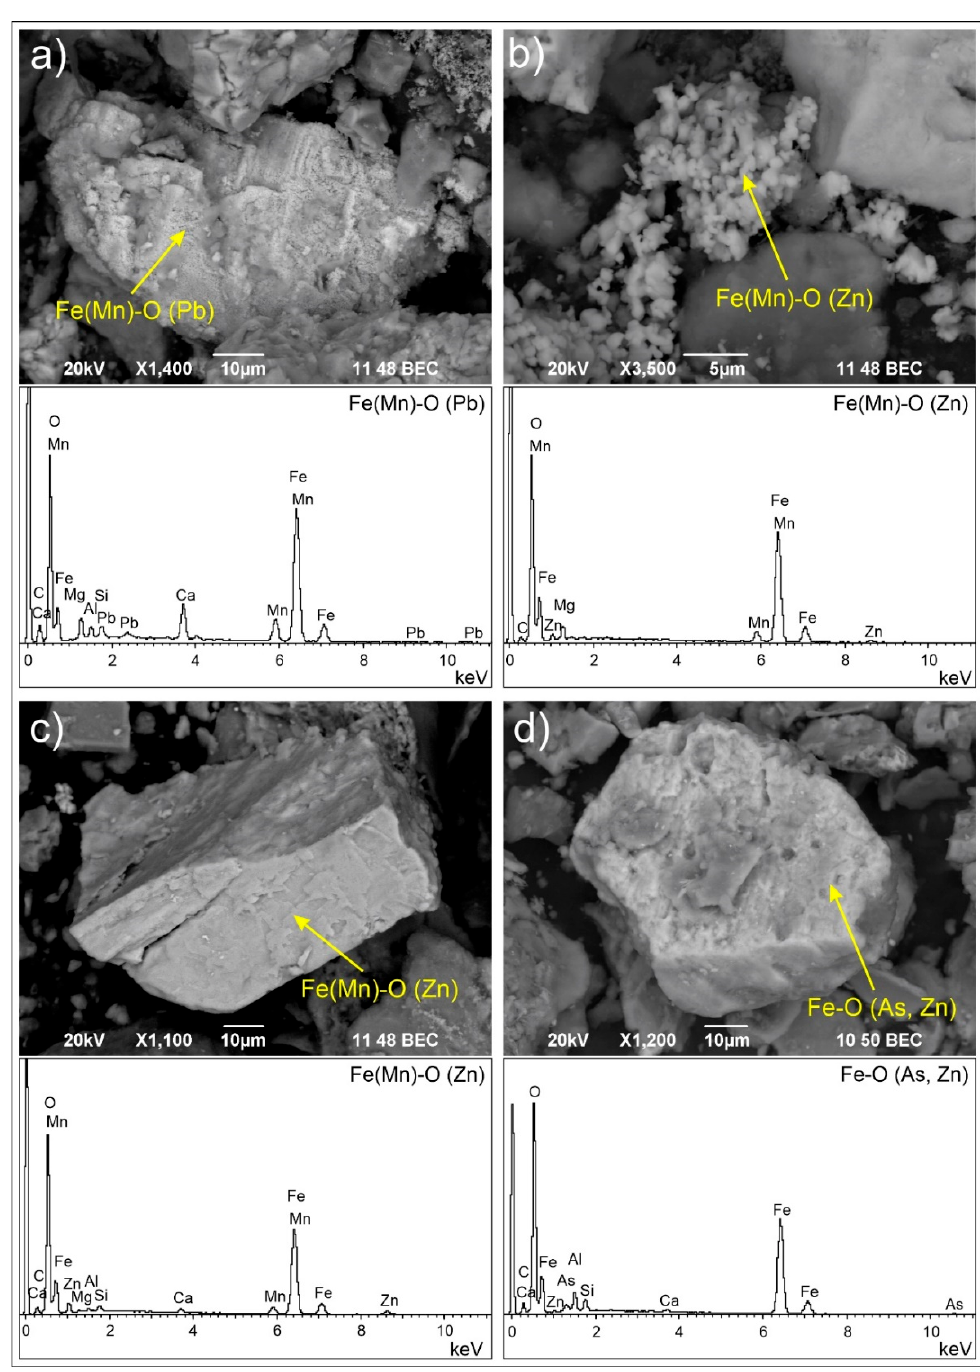
Figure 4. SEM(BSE) images and EDS spectra of solid Fe carriers in stream sediment and mine waste: ( a ) fine crystalline Fe(Mn)-oxide/oxyhydroxide coatings on an angular particle, with minor Pb content; ( b ) agglomerate of fine crystallites of Fe(Mn)-oxide/oxyhydroxide with Zn; ( c ) massive anhedral angular Fe(Mn)-O particle with minor Zn content, probably siderite; ( d ) massive anhedral subangular particle of Fe-oxide/oxyhydroxide with minor As and Zn content.